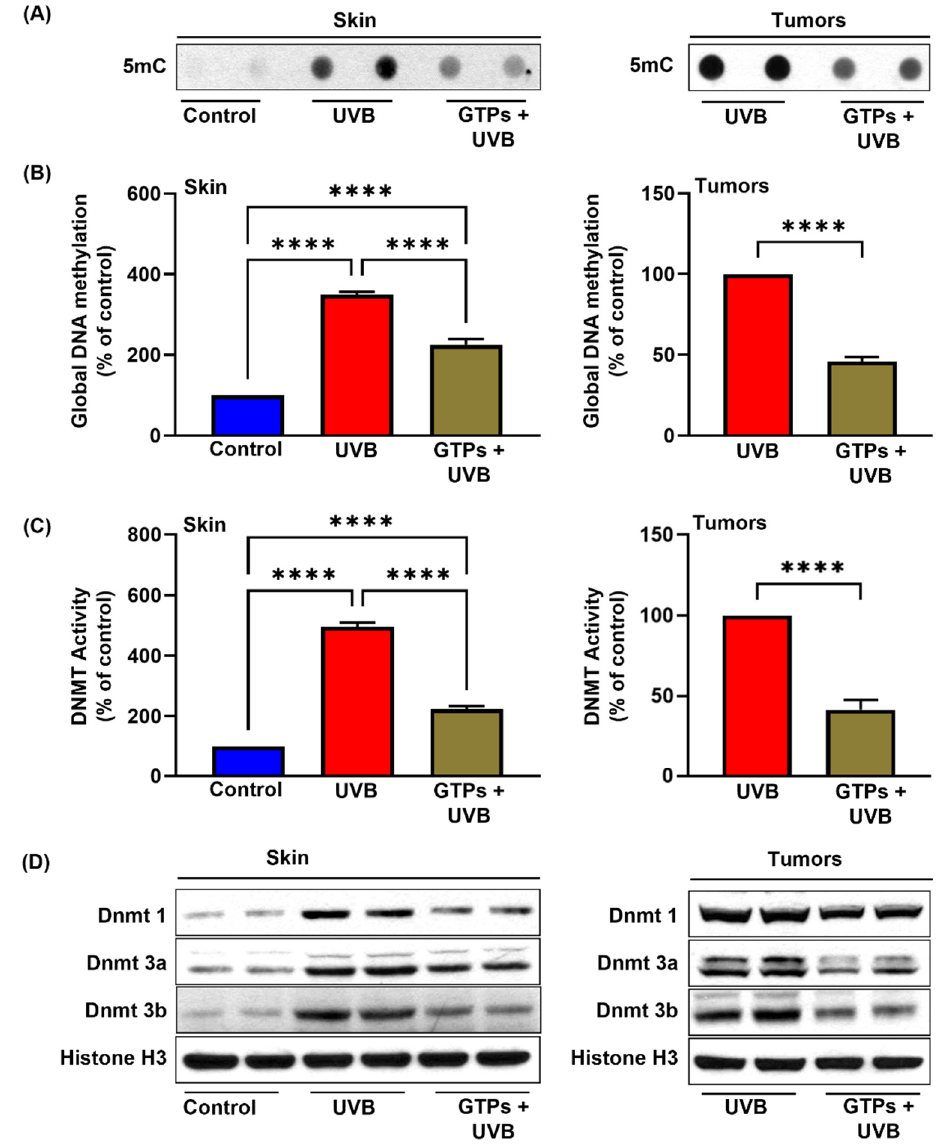
Figure 1. Effect of GTPs on global DNA methylation, DNMT activity, and protein expression in skin and tumors of SKH-1 hairless mice. At the end of the experiment, tumors and skin were harvested after euthanization of mice and subjected to DNA isolation for analysis of DNA methylation by dot blot and ELISA ( A , B ). Nuclear fractions were prepared and the effect of GTPs was observed on DNMT activity and protein expression ( C , D ). Data are presented as a percentage of control (assigned as 100%) ± S.E.M. Each column represents a pool of three samples obtained from three different mice ( n = 6). Significant inhibition between UVB alone vs. UVB + GTPs, **** p < 0.0001.